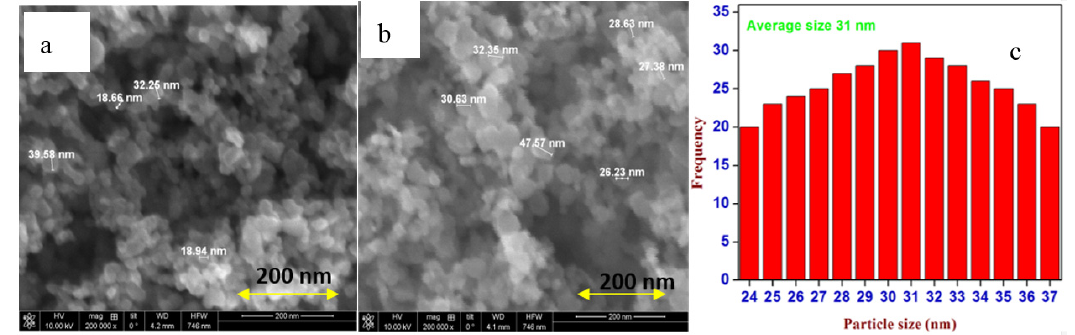
Figure 6. SEM image of ( a ) TiO 2 and ( b ) p-C/TiO 2 , respectively, and ( c ) particle size distribution of the nanosized p-C/TiO 2 .